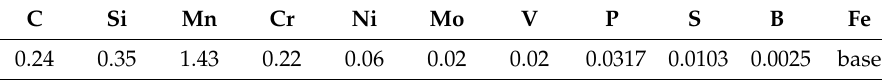
Table 1. Chemical compositions of hot-stamped steel sheets (wt %).